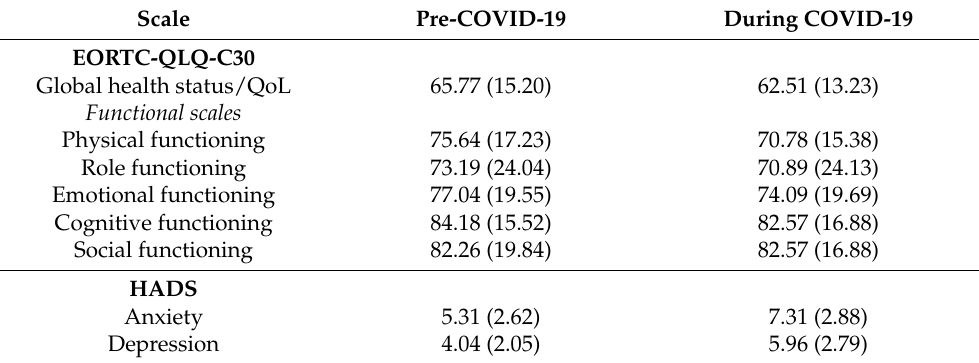
Table 2. Means and standard deviations of EORTC-QLQ-C30 and HADS scores before and during the COVID-19 pandemic.